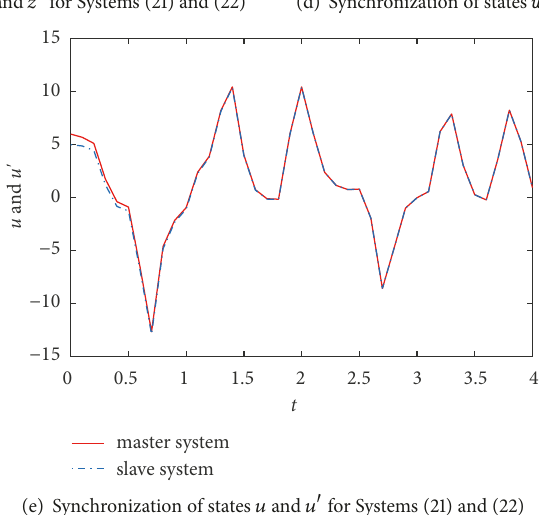
Figure 2: Synchronization of states for Systems (21) and